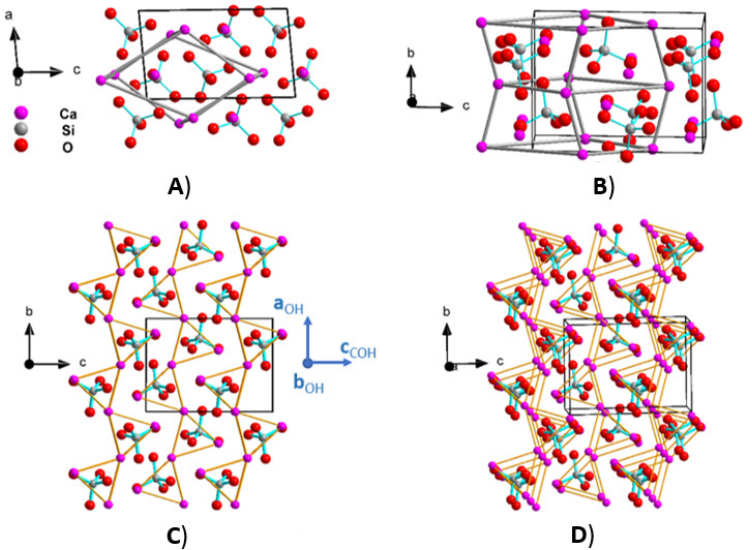
Figure 3. ( A ) The unit cell content of β -Ca 2 SiO 4 polymorph viewed along the b-axis. Light grey lines joining Ca cations indicate the orientation of the hexagonal part of the structure and ( B ) side view of unit cell content along the a-axis is shown. ( C ) View along a-axis and the packing arrangement of trigonal prisms is demarcated with orange lines. The relative orientation of the ortho-hexagonal reference system is also indicated. ( D ) A tilted view of ( C ). The Si-O bonds are indicated by cyan